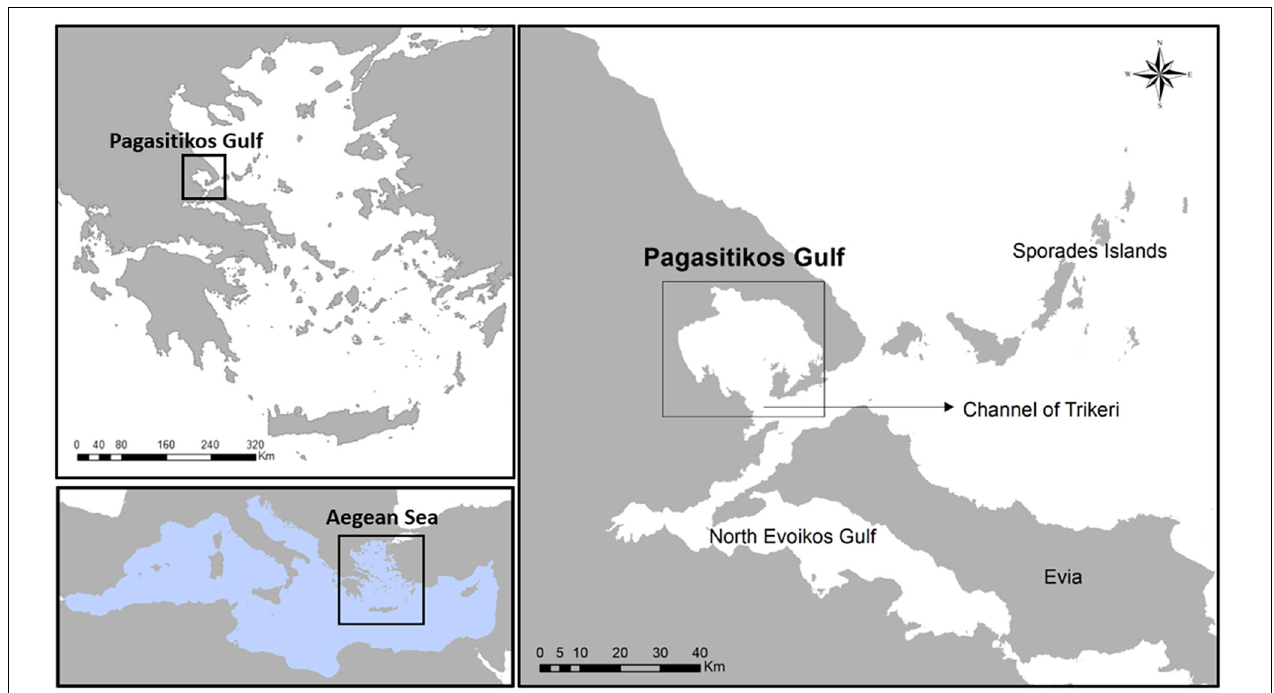
FIGURE 1 | Map showing the location of Pagasitikos Gulf in the central Aegean Sea, Greece, eastern Mediterranean Sea.